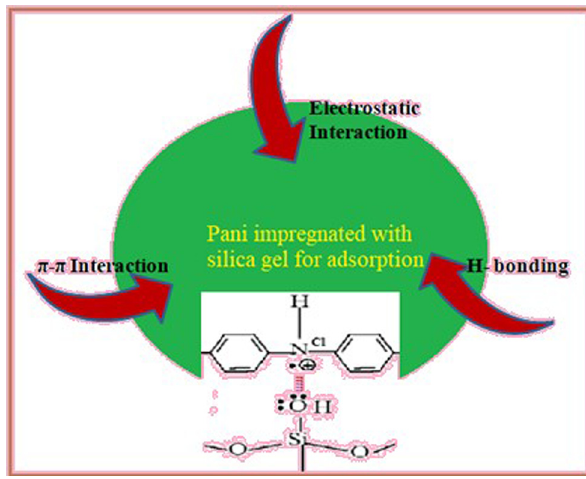
Figure 5: Scheme showing electrostatic interaction between Pani@SG possible adsorption mechanisms of